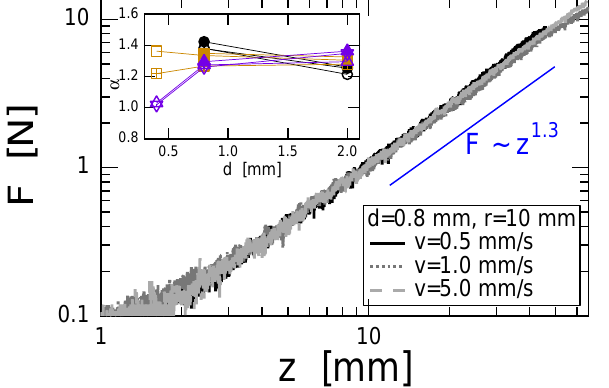
Fig. 2. Resistant force F exerted on the spherical intruder as a func- tion of penetration depth z . Different penetration speed data col- lapse to a scaling relation, F ∼ z 1 . 3 . The inset shows power law ex- ponents for various experimental conditions. Color and mark codes for the inset plot are the same as those in Fig. 4b.